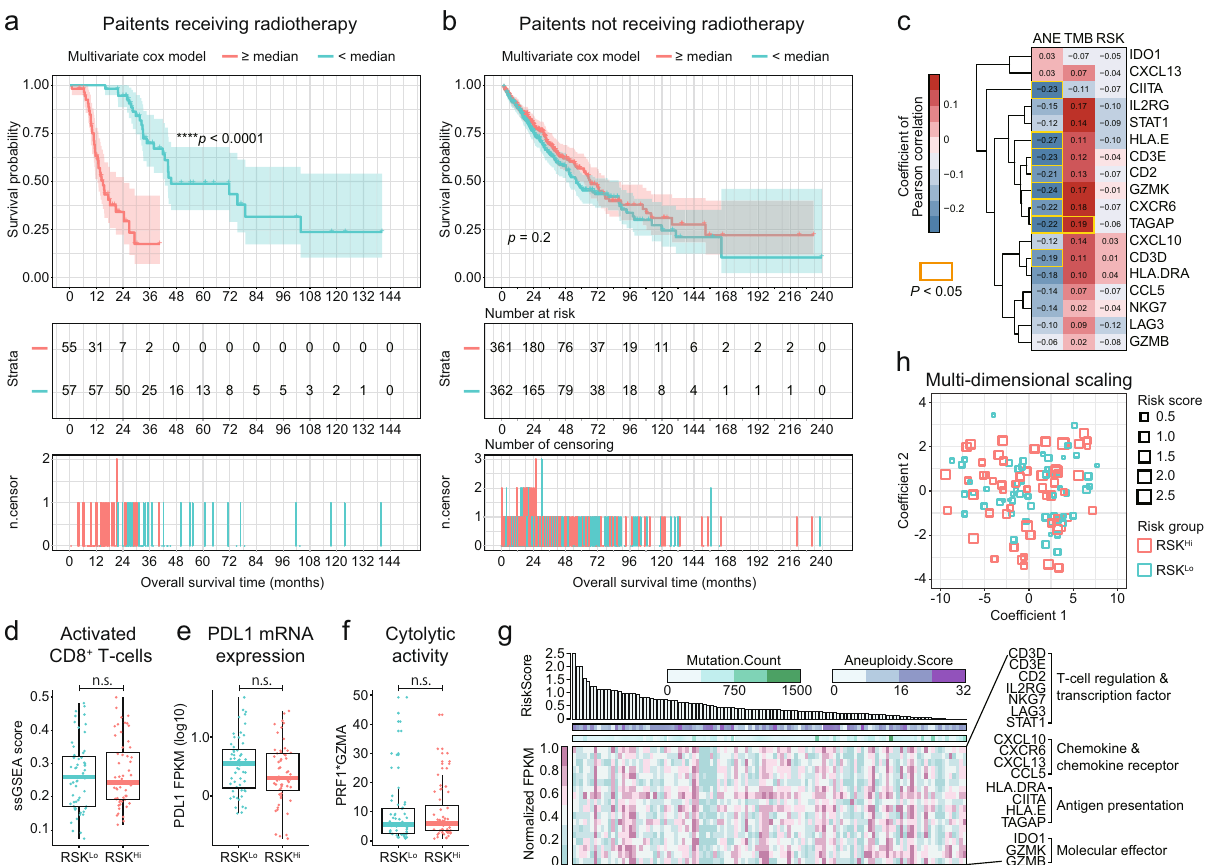
Fig. 3 Risk score predicts survival outcome and is not related to the tumor immune microenvironment. a, b Kaplan-Meier survival curves of OS (upper panel), number of risk (middle panel), and number of censoring (lower panel) patients according to the different risk scores (RSKs) for patients with ( a ) or without ( b ) radiotherapy. The hazard ratio (HR) was estimated by means of log-rank test, with 95% CI for HR shown as a dashed line. The red line indicates patients with a higher RSK, while the blue line indicates patients with a lower RSK. c Heatmap comparison of the correlation between T-cell in fl ammatory signature genes and three predictive biomarkers. Pearson correlation coef fi cients are shown. Statistically signi fi cant correlations ( p < 0.05) are outlined with yellow squares. The color gradient bar represents the correlation coef fi cient. d – f Comparison of in fi ltration of activated CD8 + T-cells ( d ), PDL1 mRNA expression ( e ), and cytolytic activity ( f ) between risk groups. Two-tailed Mann-Whitney U -test was used for all comparisons. Boxplot and error bars represent the median± range. A p ≤ 0.05 was considered statistically signi fi cant for all comparisons. g Measurement of 18 genes in an IFN- γ - related GEP for each irradiated patient. Mutation count, aneuploidy score, and RSK are annotated in the upper panel. Patients were ordered by decreasing RSK. h Multidimensional scaling (MDS) based on T-cell in fl ammatory signature genes. The color and size of each square indicates the risk group and score for each comprising 34 patients who were diagnosed and sampled at three hospitals (Supplementary Data 4). TMB and ANE were calculated based on pretreated tumor tissues using established methods (Supplementary Data 4). Comparison of the baseline between the discovery and validation cohorts is shown in Supplementary Data 5. For the predictive signi fi cance of TMB or ANE alone, both individual predictors showed consistent impact on the survival outcome for patients receiving radiotherapy (TMB, cutoff TMB = 185 or 5.95/Mb, p = 0.2859, HR = 0.6181; ANE, cutoff ANE = 22, p = 0.8117, HR = 1.109). However, their pre- dictive values remain statistically insigni fi cant in our validation cohort, probably due to the limited cohort size. In the assay of their integrated RSK, we identi fi ed signi fi cantly favorable survival outcome for patients with lower RSK (Fig. 4a, * p = 0.0128, HR = 2.38, 95% CI, 1.054 – 5.373). Furthermore, by comparing the RSKs between patients progressed and not progressed at 180 days (Fig. 4b, * p = 0.0227) and 360 days (Fig. 4c, ** p = 0.0047), respectively, we observed consistently and signi fi cantly lower RSKs for patients with durable survival time, further supporting the predictive value of RSK in radiation treatment.